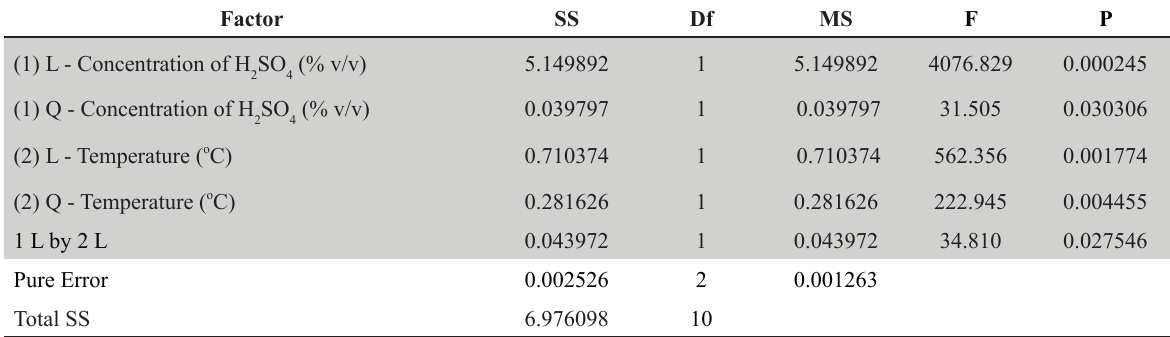
Acid hydrolysis optimization - ANOVA statistics data of independent variables and their interactions; dependent variable (RC concentration